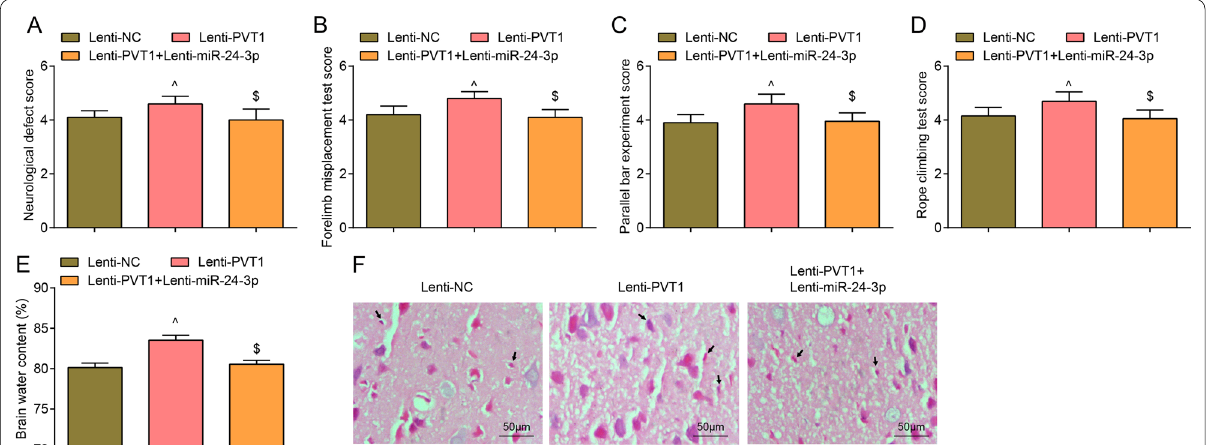
Fig. 5 Restored miR-24-3p abolishes PVT1 overexpression-induced neurological impairment, motor behavioral disorder and pathological damage in MCAO rats. A Neurological defect scores of rats in each group after PVT1 overexpression and miR-24-3p up-regulation (n 8 rats per group); B = Forelimb foot fault placing test scores of rats in each group after PVT1 overexpression and miR-24-3p up-regulation (n 5 rats per group); C Parallel = bar experiment scores of rats in each group after PVT1 overexpression and miR-24-3p up-regulation (n 5 rats per group); D Rope climbing test = scores of rats in each group after PVT1 overexpression and miR-24-3p up-regulation (n 5 rats per group); E Brain water content of rats in each = group after PVT1 overexpression and miR-24-3p up-regulation (n 8 rats per group); F HE staining of rat brain injury in each group after PVT1 = overexpression and miR-24-3p up-regulation ( 200; scale bar 50 μm, n 8 rats per group; arrow indicated that the nucleus of neurons appears × = = with pyknosis); ^ P < 0.05 compared with the Lenti-NC group; $ P < 0.05 compared with the Lenti-PVT1